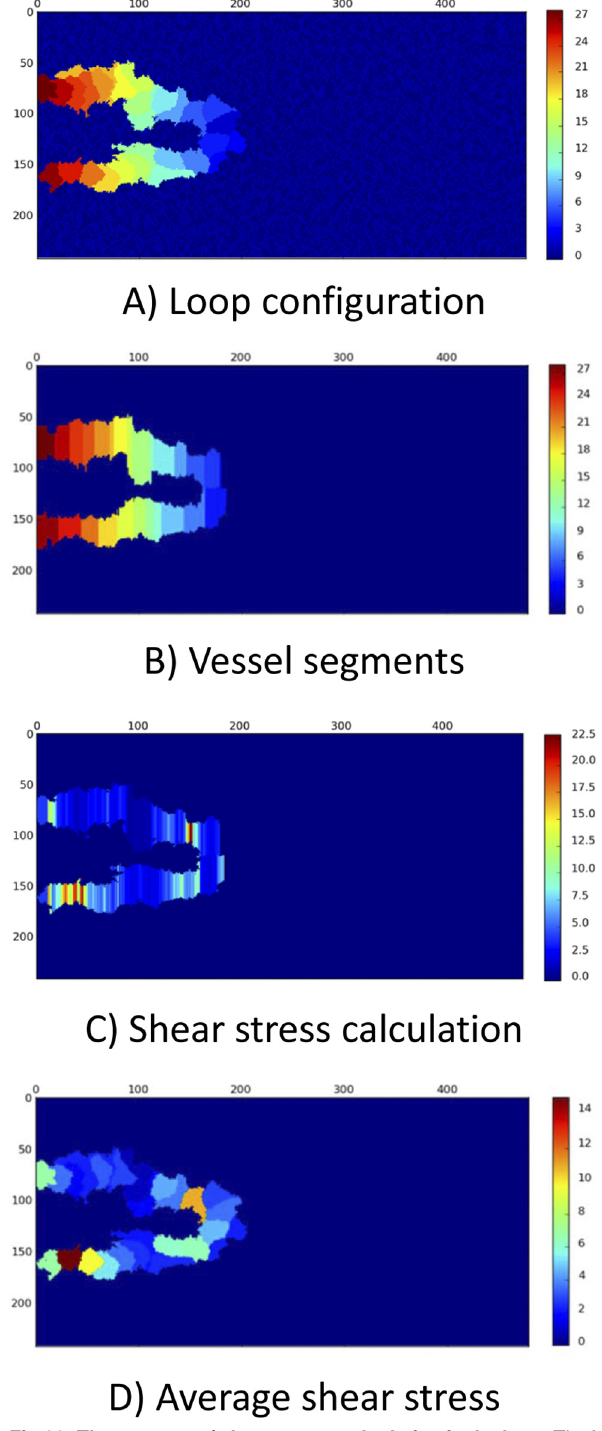
Fig 11. The process of shear stress calculation in the loop. The X and Y-axis show the domain size in μ m. A) The configuration of the loop changes in each MCS. The loop configuration is the input to the flow calculation procedure. The color bar shows the EC identity in the solution. B) The current configuration of loop is approximated by vessel segments. Some geometrical simplifications may be required. The color bar is identity of ECs in the solution. Based on the portion of each EC in segments, each segment is assigned to specific EC. C) The pressure, flow, and shear stress are calculated in each segment. The color bar